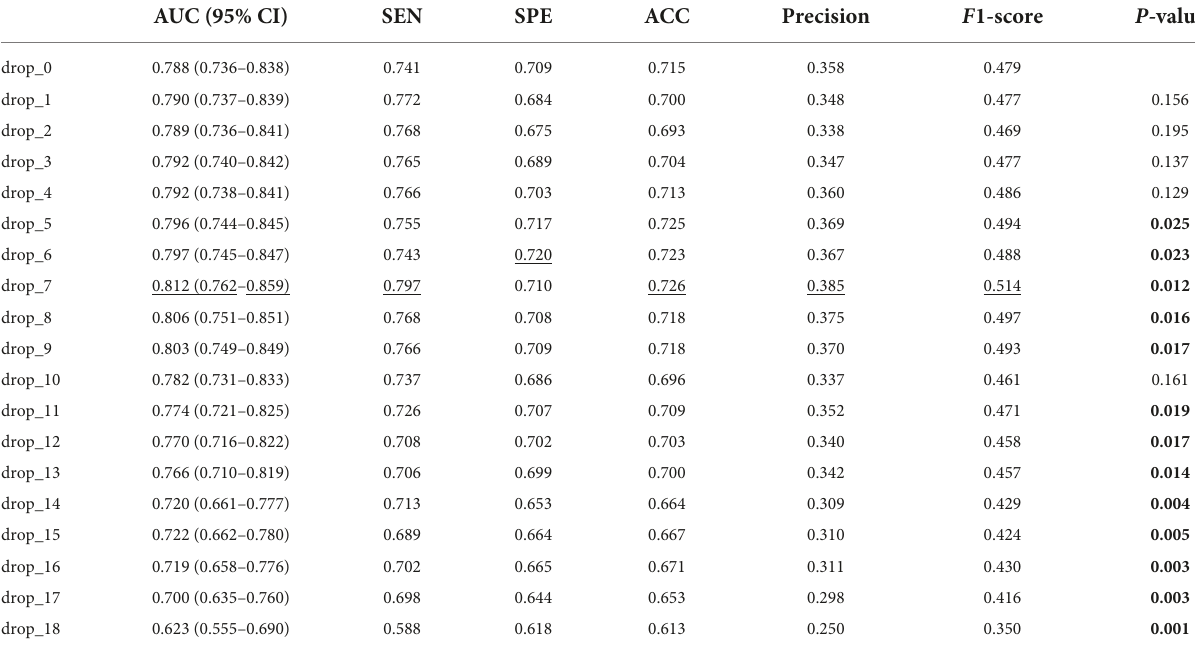
TABLE 5 Discrimination performance of our model after dropping variables with poor prediction